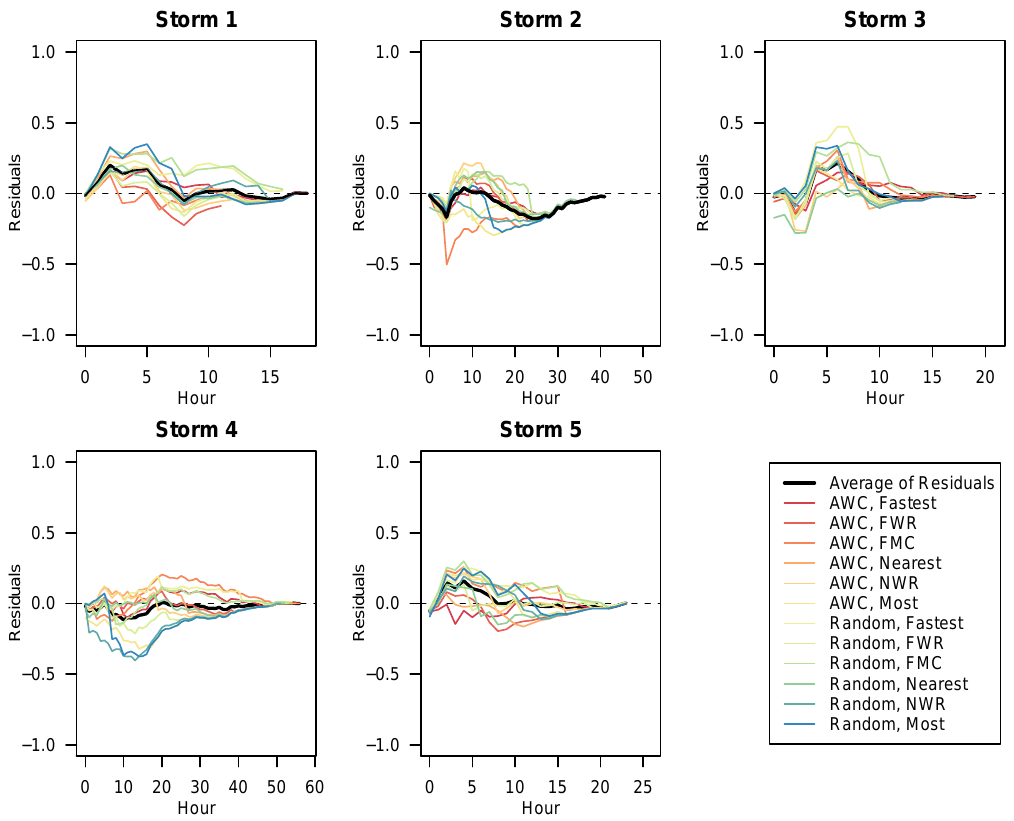
Figure 3. Plot of the residuals normalized to the maximum number of customers affected for each storm in Figure 2 for each of the crew start and search strategy combinations. FRT is fastest repair time, FWR is fastest repair time within radius and FMC is fastest repair time and most customers